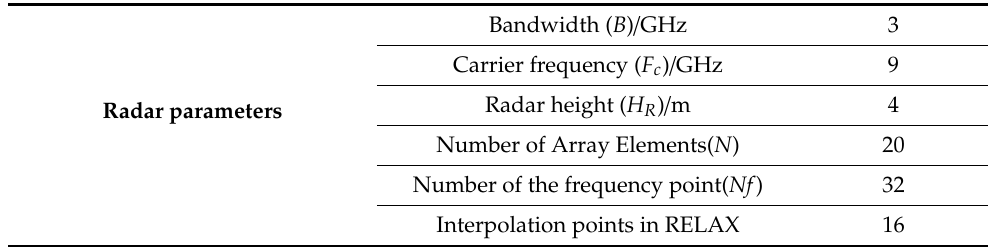
Table 1. Simulation